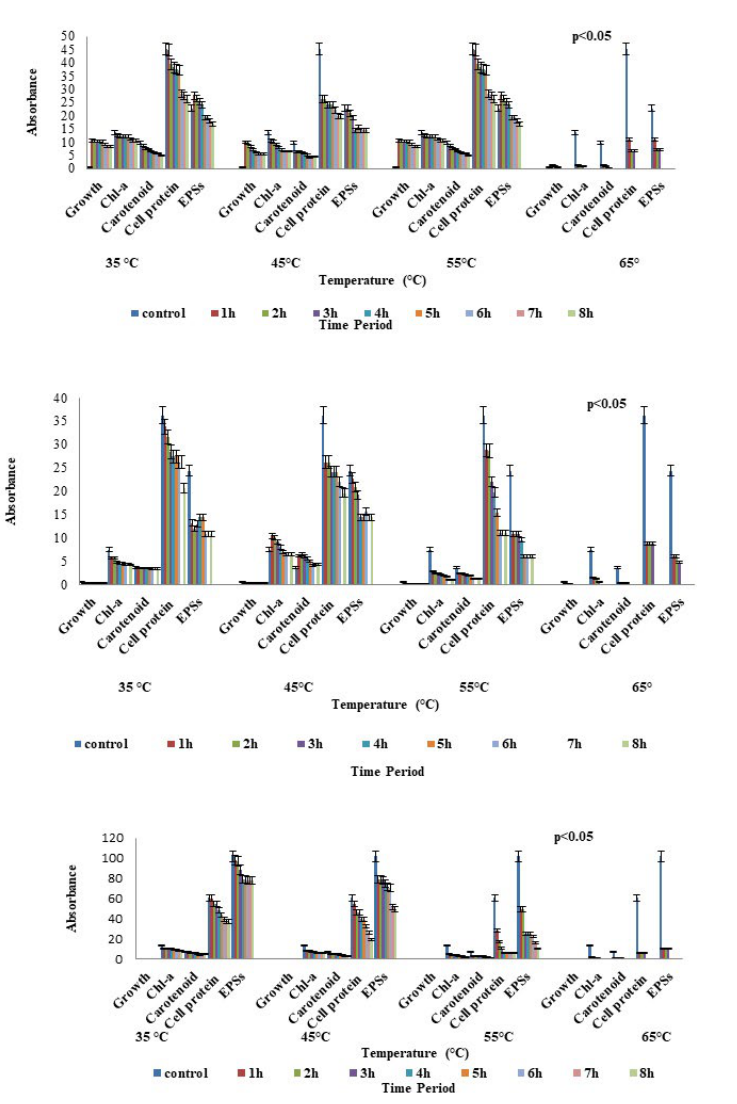
Fig. 2. Growth response, chlorophyll – a , carotenoid, soluble cell-protein, and extracellular polysaccharides content of three sub-aerial cyanobacteria, (a) Scytonema coactile (limestone,Gupteswar cave), (b) Scytonema geitleri (lime- washed wall, Building) and (c) Lyngbya aerugineo-coerulea (Stone carving, Bhaskareswar Temple) upon exposure to various temperature. Homogenized suspension of the organism was subjected to heat treatment (Temp. 35°C-65°C for up to 8h) and then cultured at 25 ± 1°C for 15